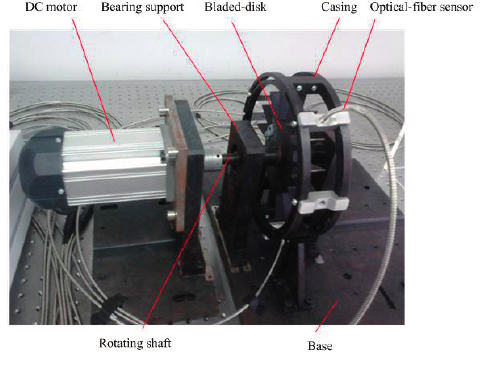
Figure 15. The test rig.